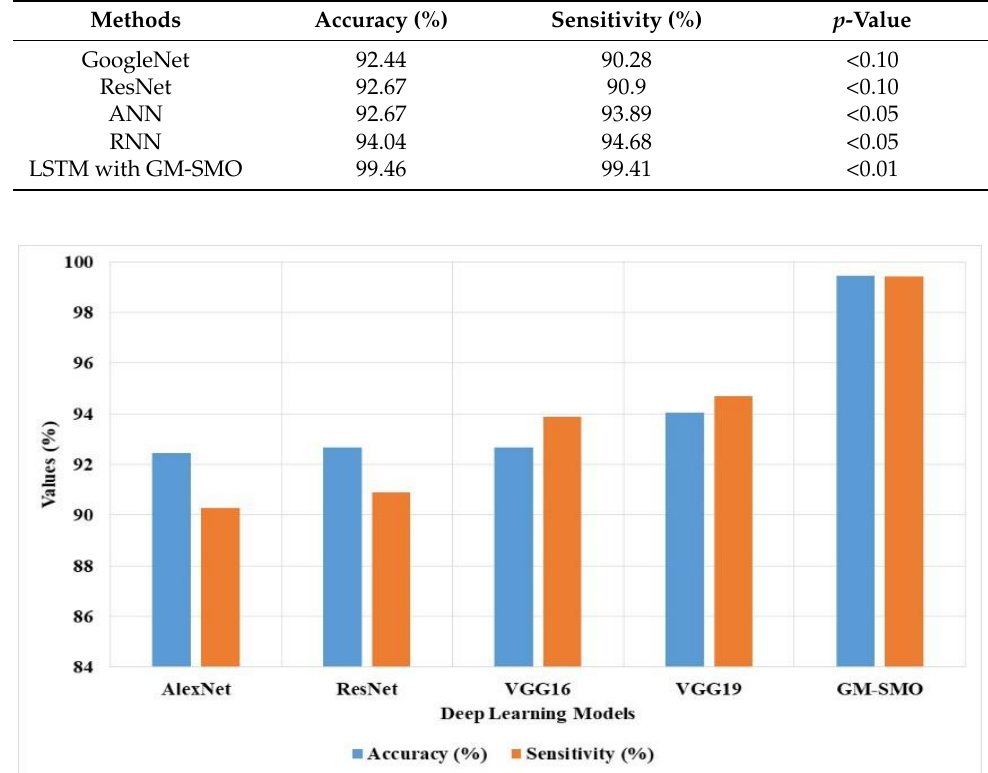
Table 1. Deep learning techniques ’ performance in scene classification on three datasets.